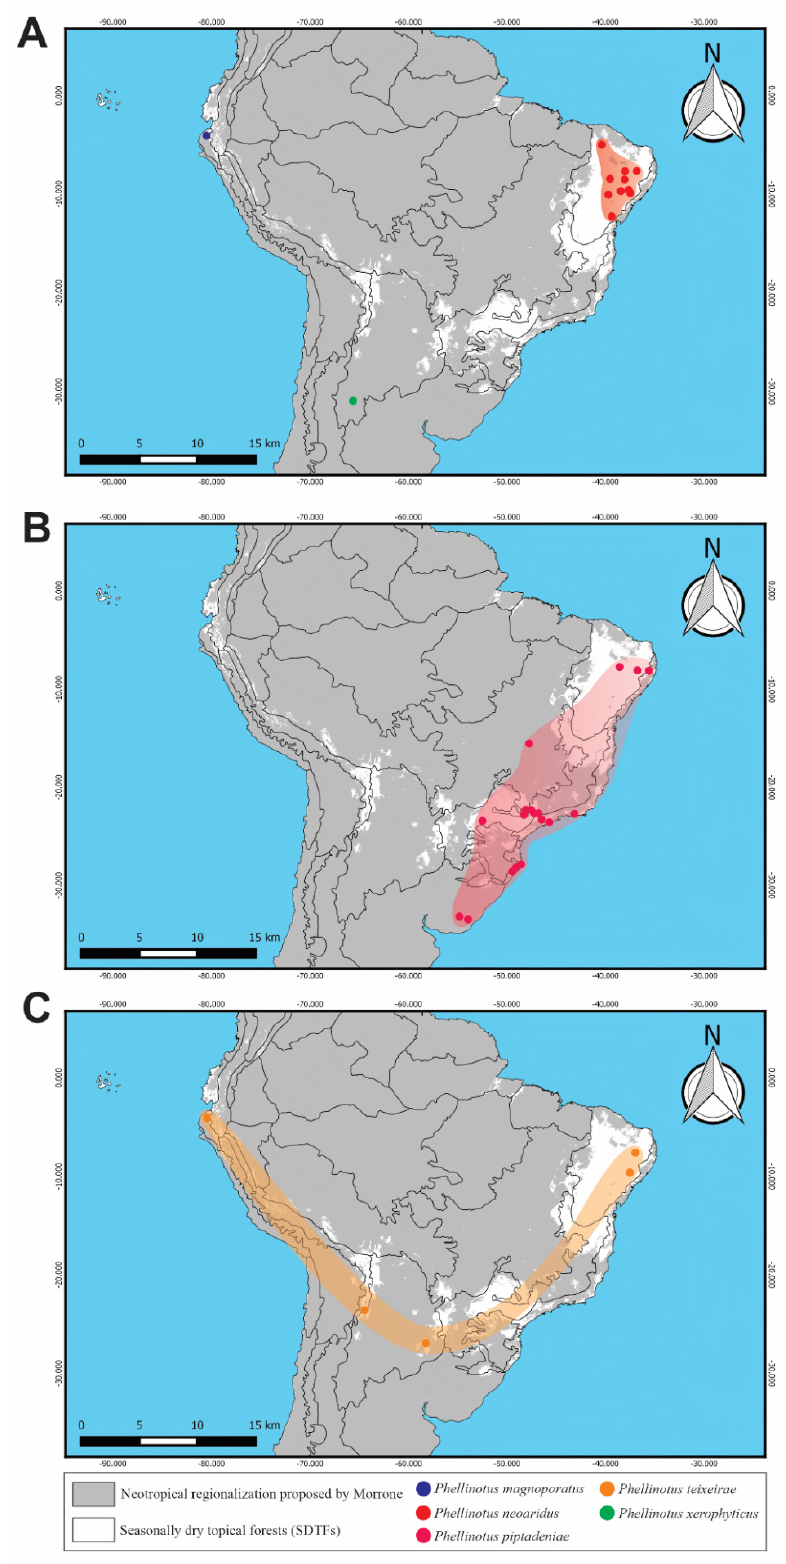
Figure 11. Comparison of the geographical distribution of Phellinotus species in South America: ( A ) Phellinotus magnoporatus , P . neoaridus , and P . xerophyticus ; ( B ) Phellinotus piptadeniae ; ( C ) Phellinotus teixeirae (the colored shadows show the distribution patterns of Phellinotus species).